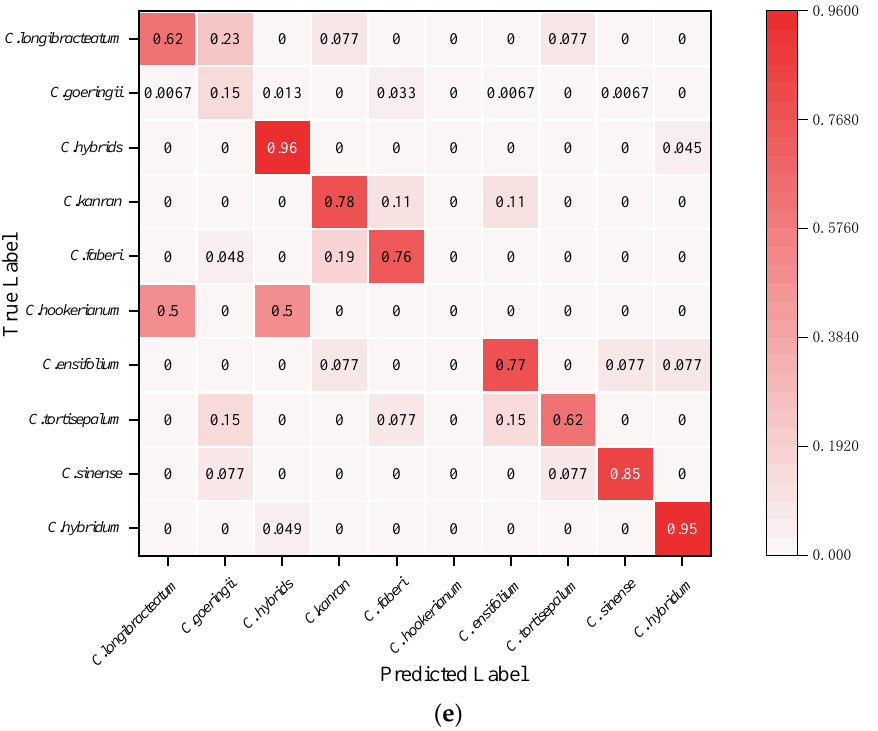
Figure 5. Test set confusion matrix: ( a ) GL-CNN; ( b ) AlexNet; ( c ) ResNet; ( d ) GoogleNet; ( e ) VGGNet.